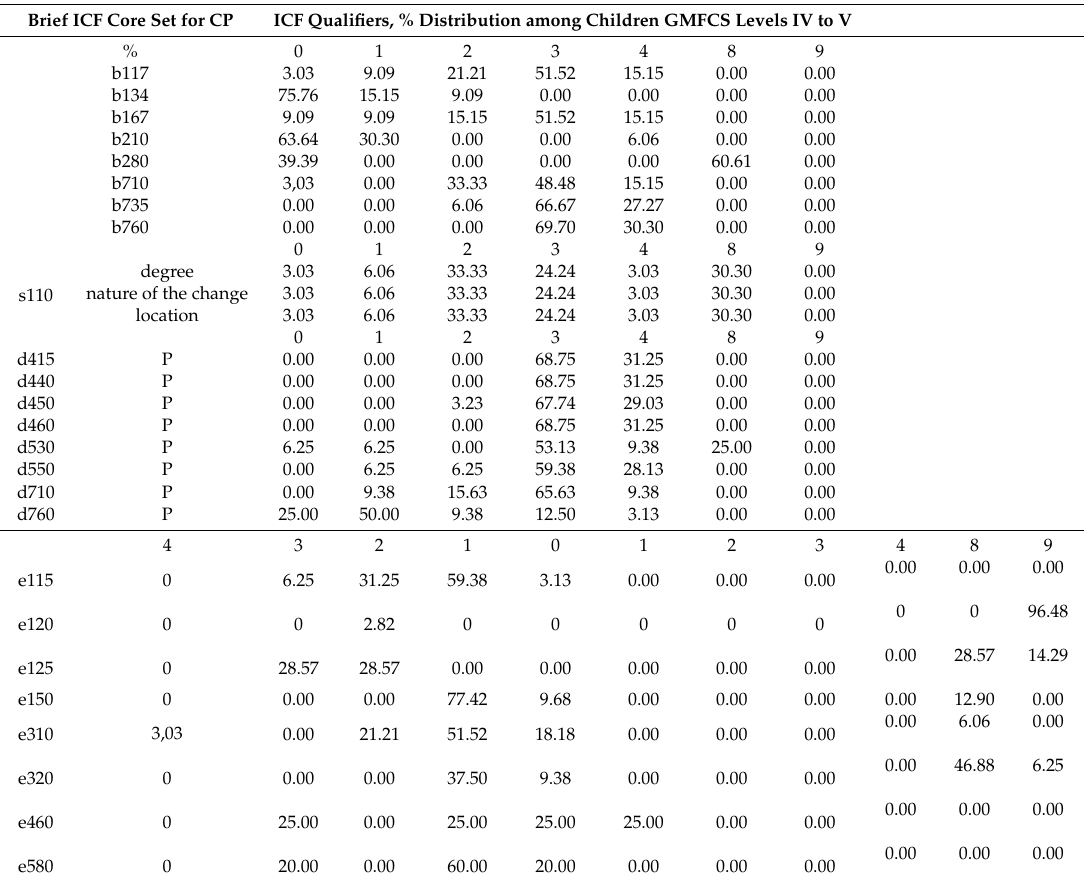
Table 3. Functioning profile of the Russian children with CP, GMFCS levels IV to V ( n = 68). Brief ICF Core Set for